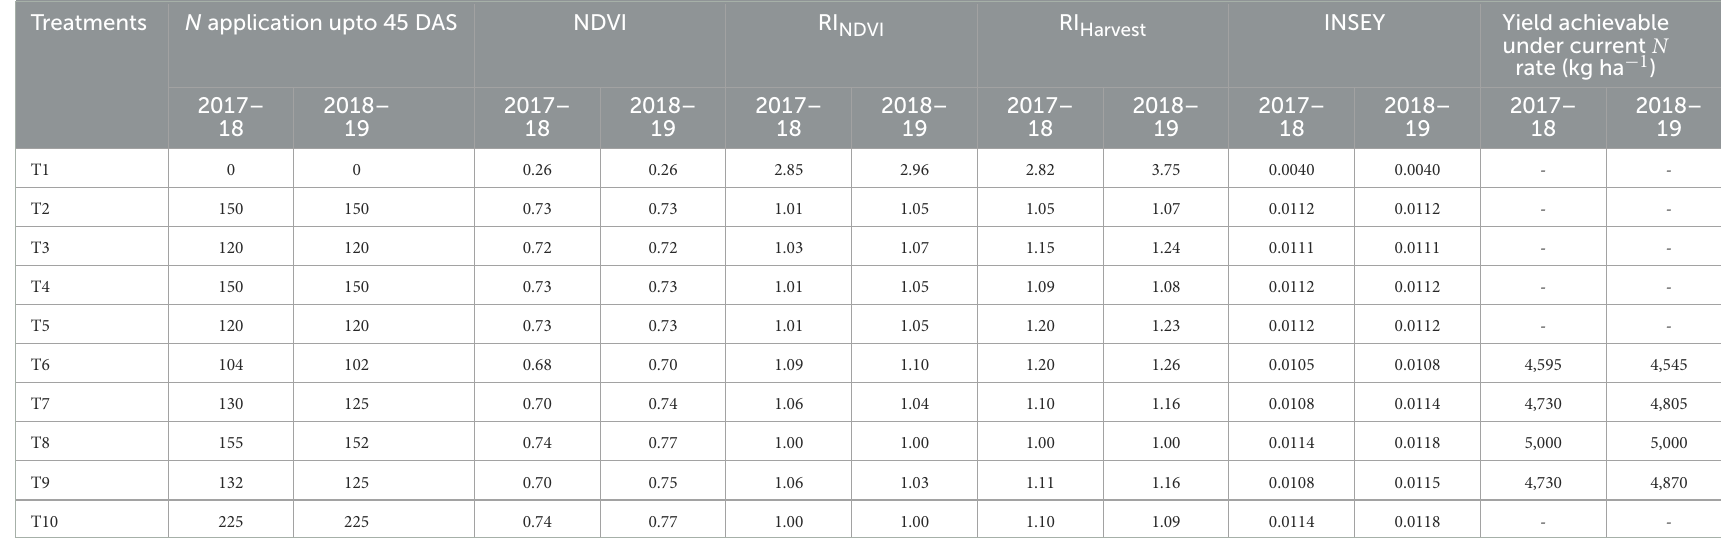
TABLE 2 Evaluation of NDVI sensor-based N management in wheat at 65 days after sowing. Treatments N application upto 45 DAS